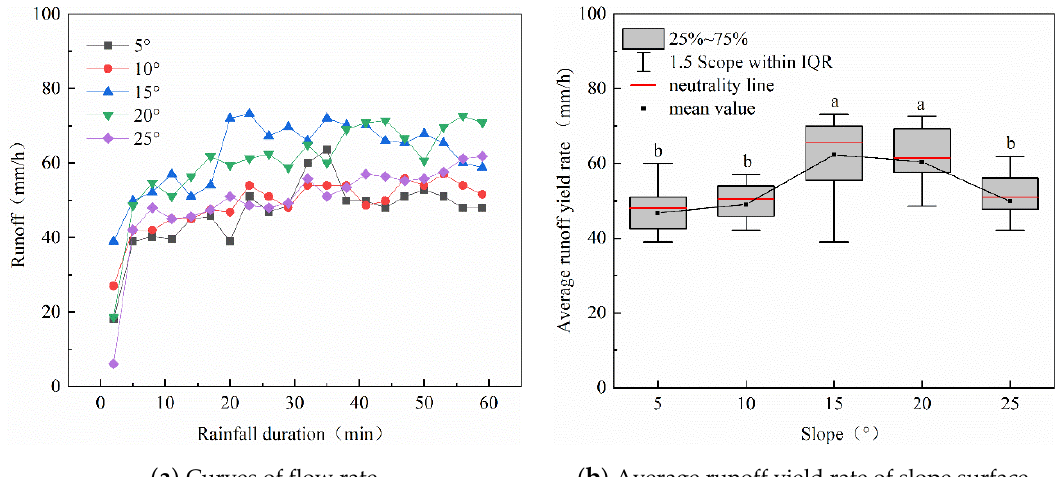
Figure 3. The influence of different slopes on the yield rate.